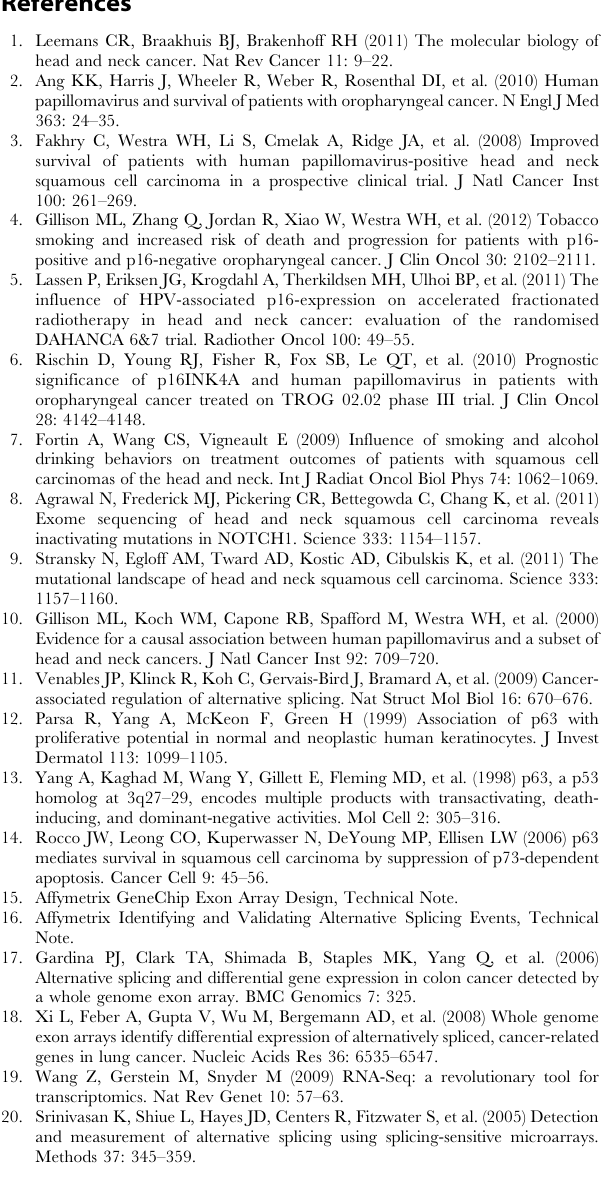
Table S1 Splice variant-specific custom primer and probe sequences. Table S2 MMES Gene Rank